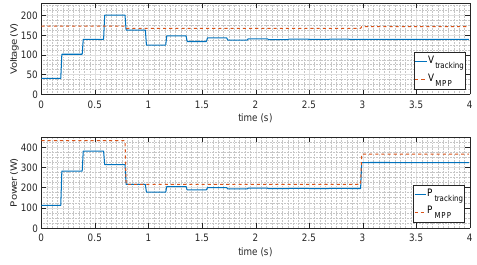
Figure 22. Tracking profile of GSS under sudden irradiance